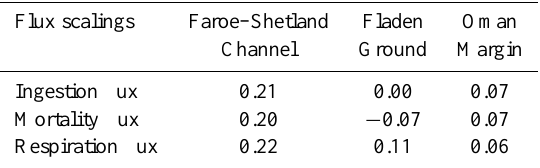
Table 6. Scaling of flux terms in Eq. (1) with size for the three study